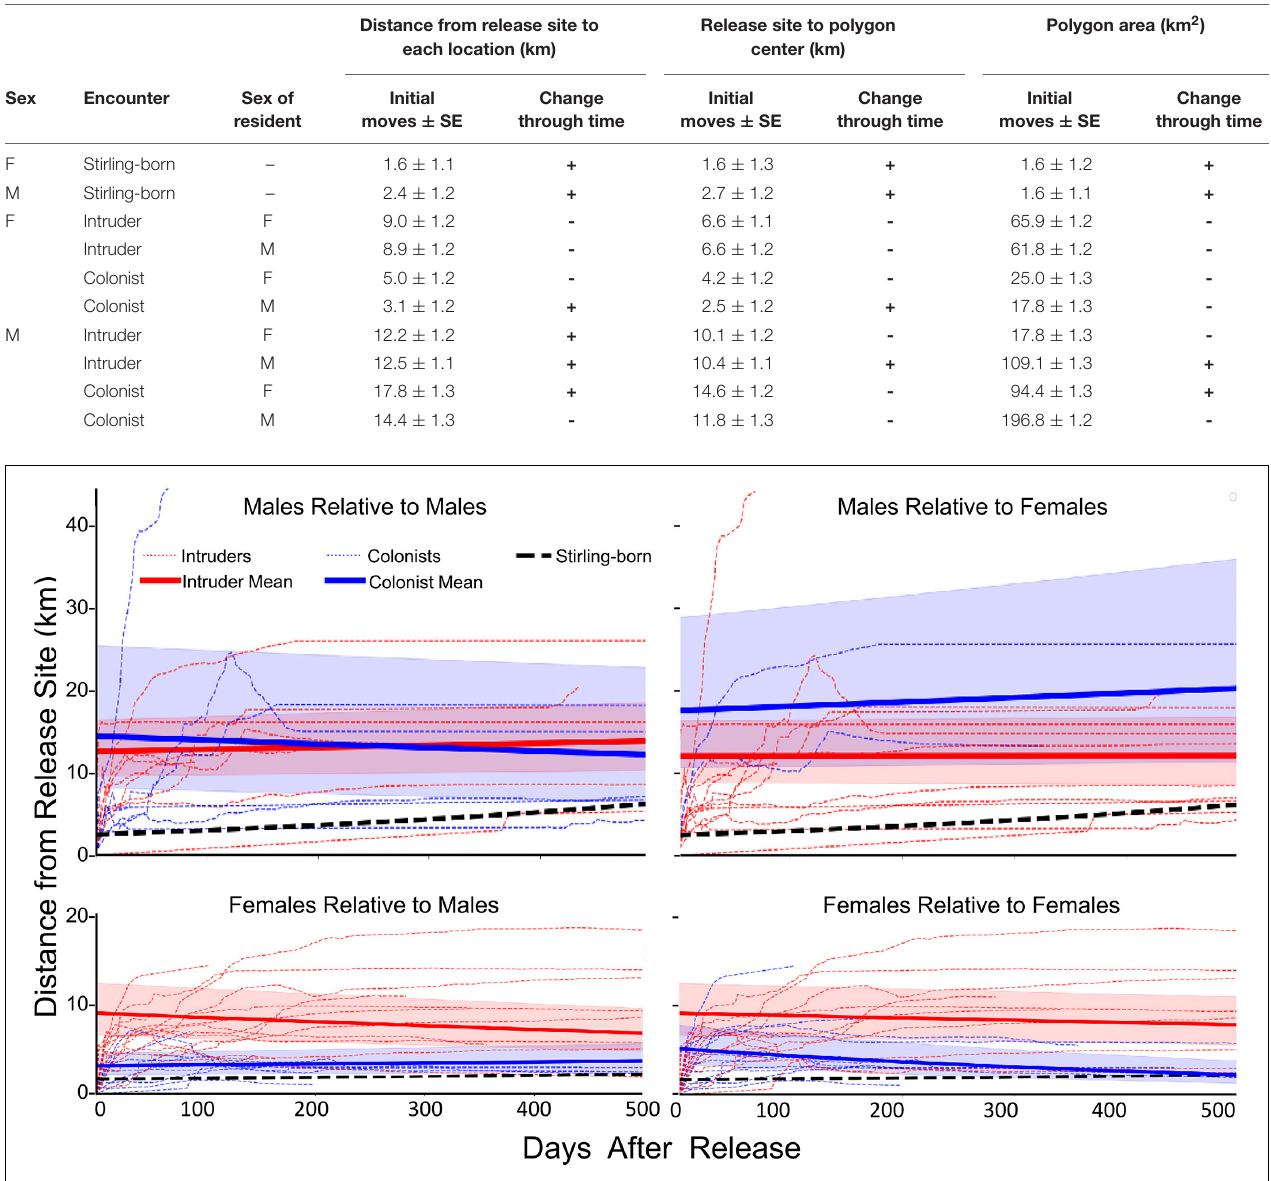
FIGURE 5 | Running mean distances (light red and blue dashed lines) from the sites of initial release following translocation for individual male (upper panels) and female (lower panels) fishers and the fitted mean distances for fishers released onto the established home ranges of previously released fishers (Intruders, red solid lines) and sites unoccupied by fishers (Colonists, blue lines) compared to fishers that were born on the study site (solid black lines). The y-intercepts represent initial movements from release